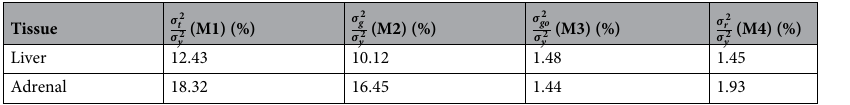
Table 1. Variance components estimated by the mixed models (M1–M4) expressed as the percentage of the 2 total variance of y . σ t the transcript variance, 2 pathway variance, σ y the variance of log 2